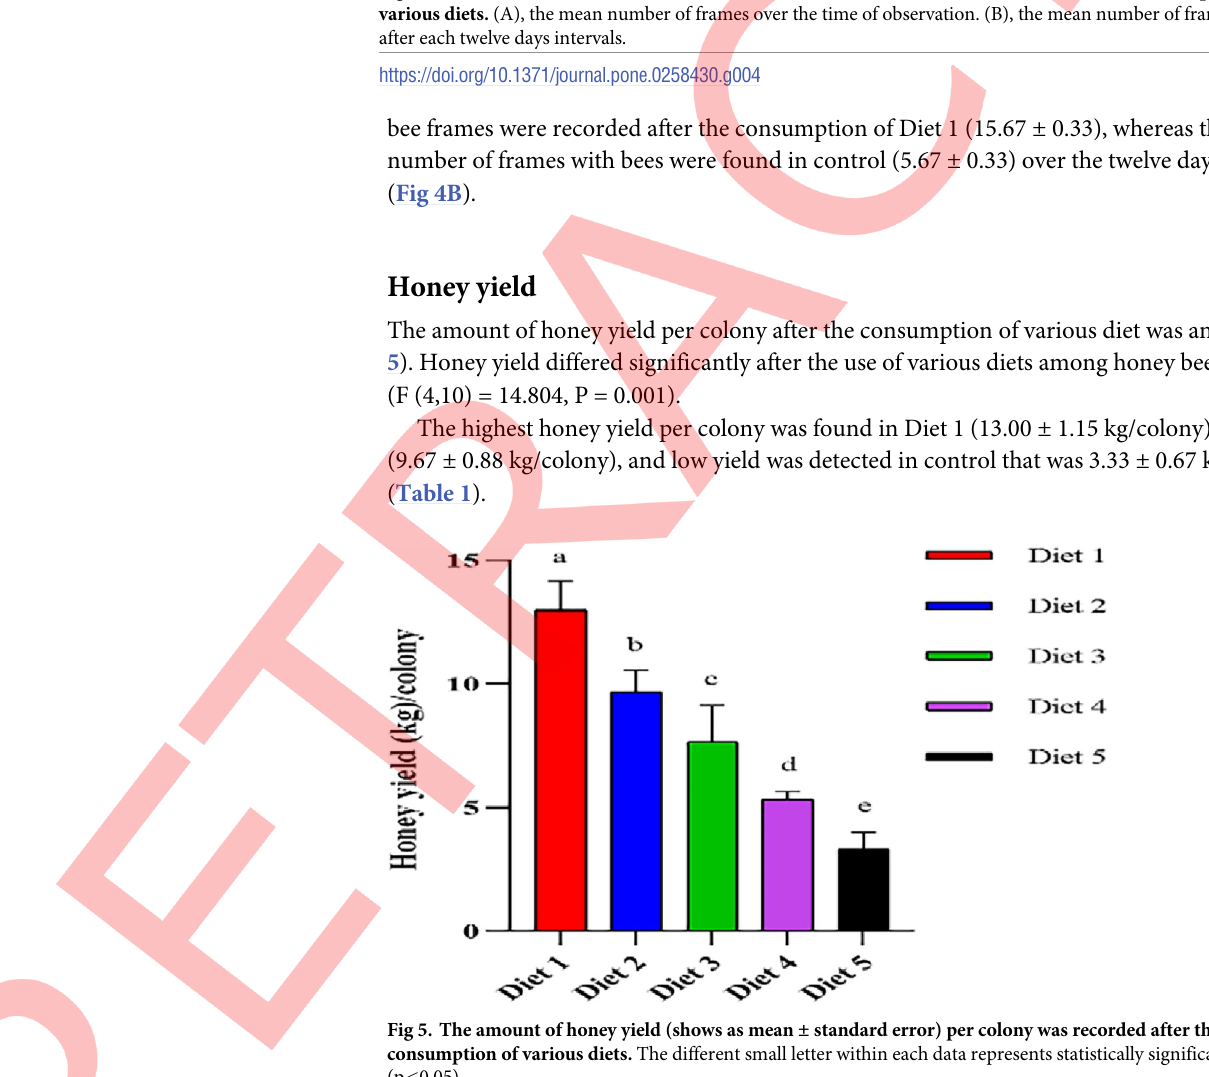
Fig 5. The amount of honey yield (shows as mean ± standard error) per colony was recorded after the consumption of various diets. The different small letter within each data represents statistically significant differences (p <